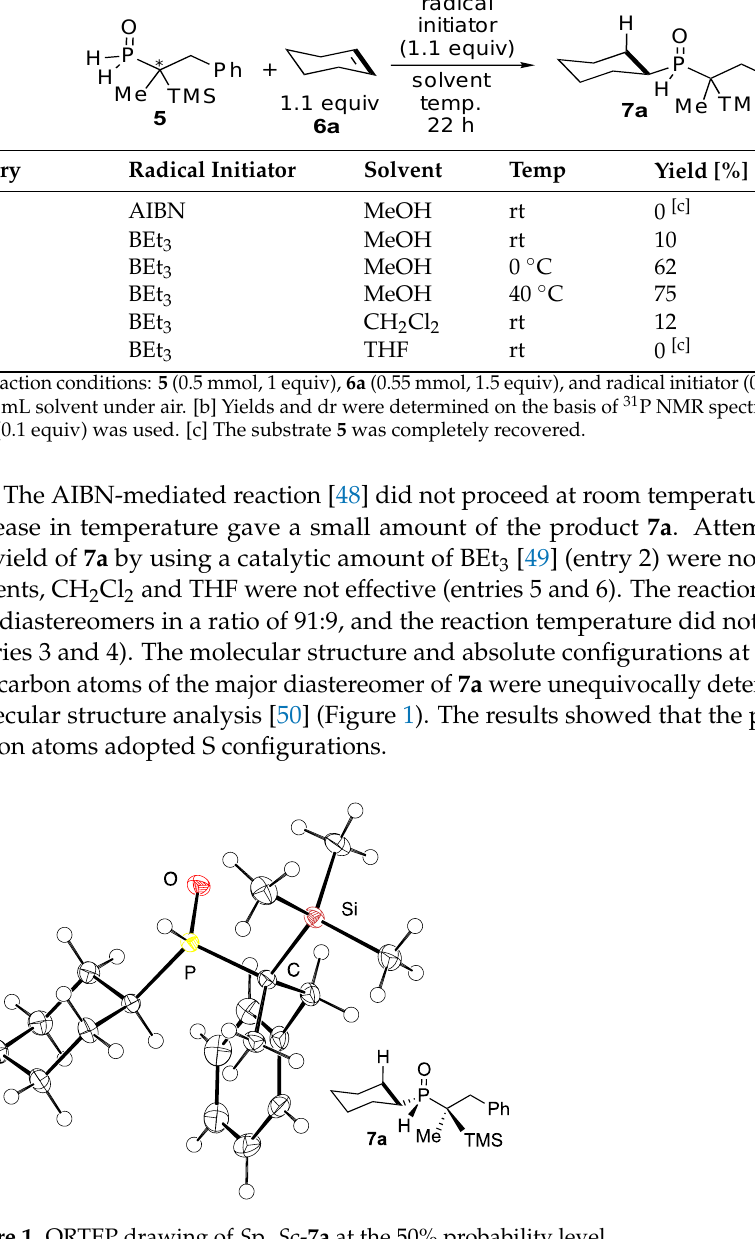
Figure 1. ORTEP drawing of S p. S c- 7a at the 50% probability level. The reaction in Table 1 should begin with the formation of phosphorus-centered radical 8 [51] (Figure 2), which then adds to the alkene 6a . To elucidate the structure of 8 , molecular orbital calculations at the UHF/6-31G (d, p) level of theory [52] were carried out. The results showed two stable diastereomers: 8a and 8b , whereby the radical center at the phosphorus atom was oriented in the same or opposite direction toward the carbon-silicon bond. The diastereomer 8b was more stable than 8a by about 0.5 kcal/mol. The relative stability of the major product 7a and its diastereomer 7a (cid:48) was also estimated by DFT calculations at the B3LYP/6-31G (d, p) level of theory. On the basis of these calculations, interconversion of the phosphorus radicals 8a and 8b may be possible, but 8b may mainly attack cyclohexene to form thermodynamically stable diastereomer 7a . mediated addition reaction conditions (Table 2). Terminal alkenes having hydroxy, trime- thylsilyl, acetyl, acetoxy, and acetal groups 6b – 6g reacted with the phosphorus-centered radical generated from 5 to give the corresponding products 7b – 7f (entries 1 – 5).